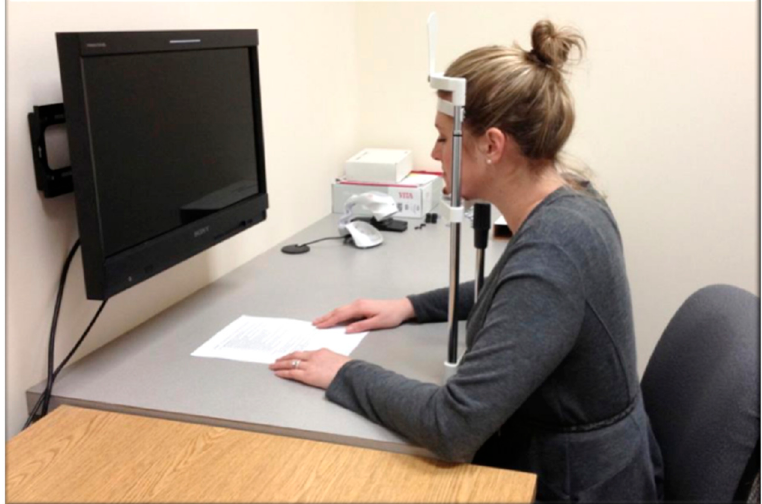
Figure 7. Subject positioning and setup for evaluating monitor image.